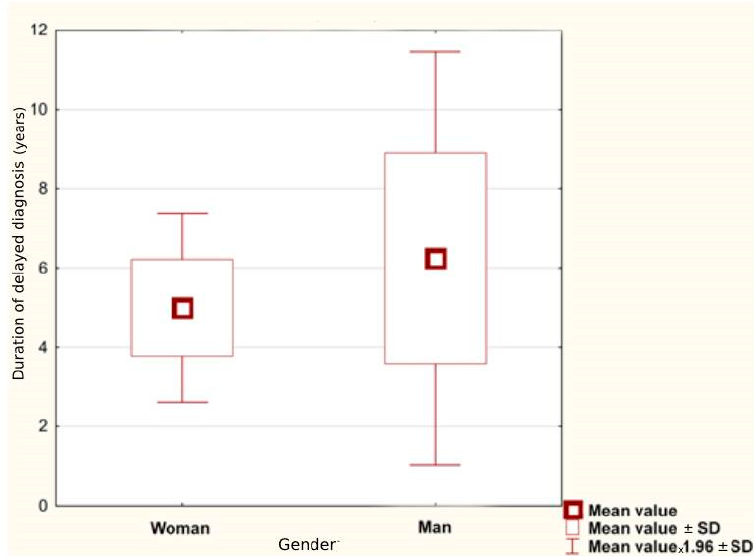
Figure 1. Duration of delayed diagnosis in women and men (average value in years).